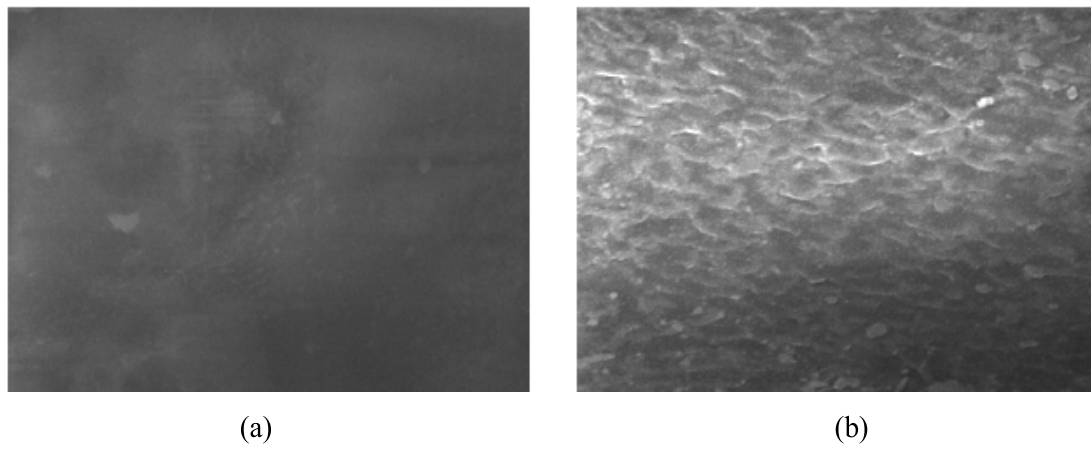
Figure 9. Surface morphology of untreated ( a ) and plasma-treated PVC ( b ) obtained from scanning electron microscopy (Reproduced with permission from [50]. Copyright 2010 MDPI).